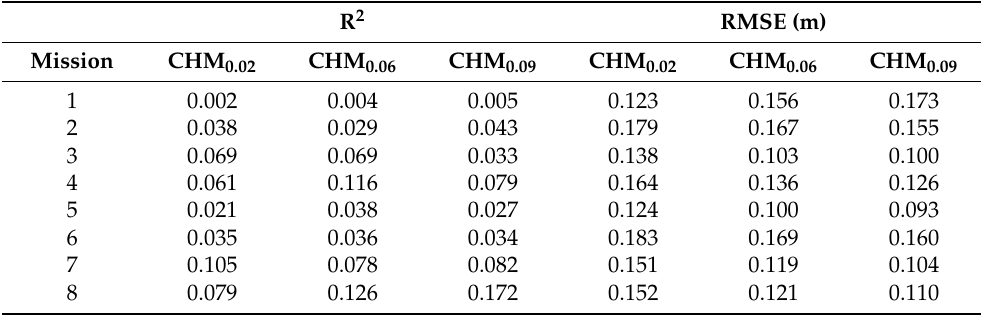
Table 8. Analysis of canopy height model accuracy. The CHM resolution is indicated in the subindex with 0.02, 0.06, and 0.09 m/pixel, respectively. RMSE: root mean squared